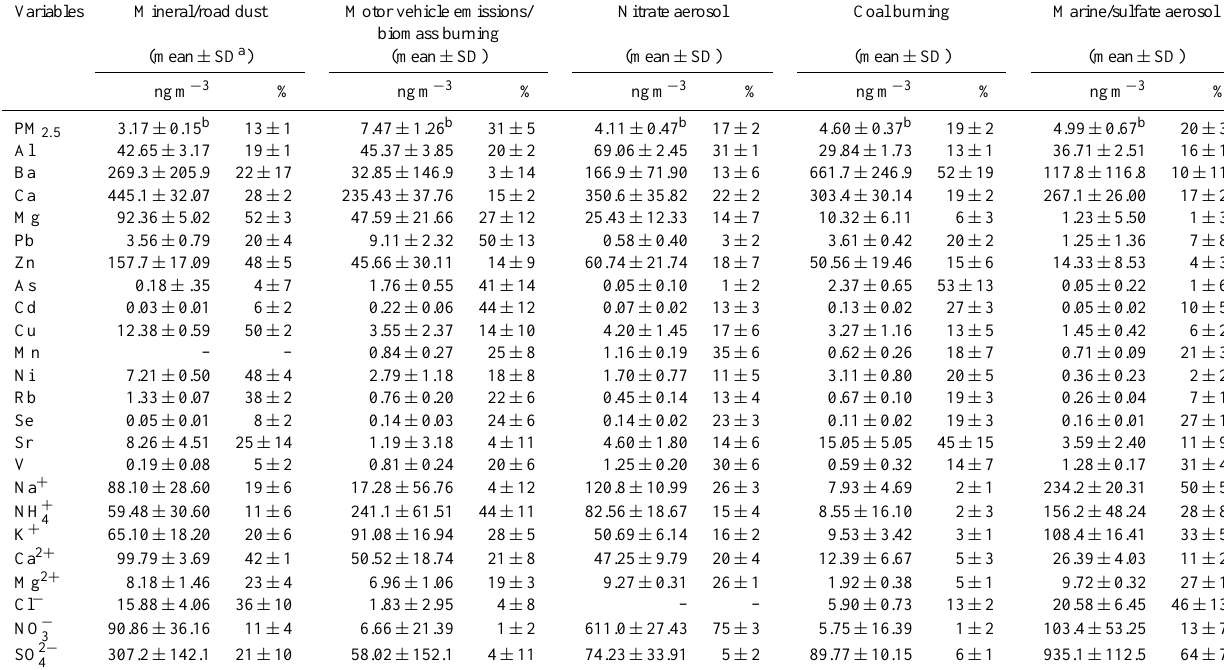
Table 2. The contribution of sources to PM 2 . 5 and the compositions estimated by PMF 5.0 model. Variables Mineral/road dust Motor vehicle